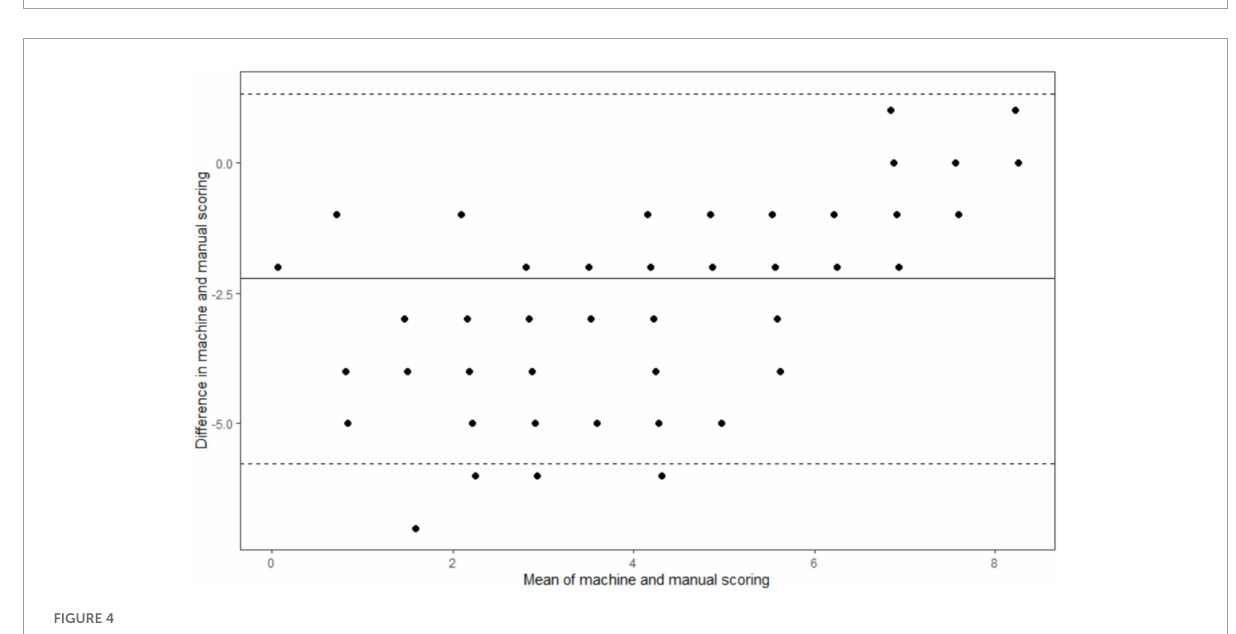
FIGURE3 Participants test score on the DCS by cognitive outcomes.